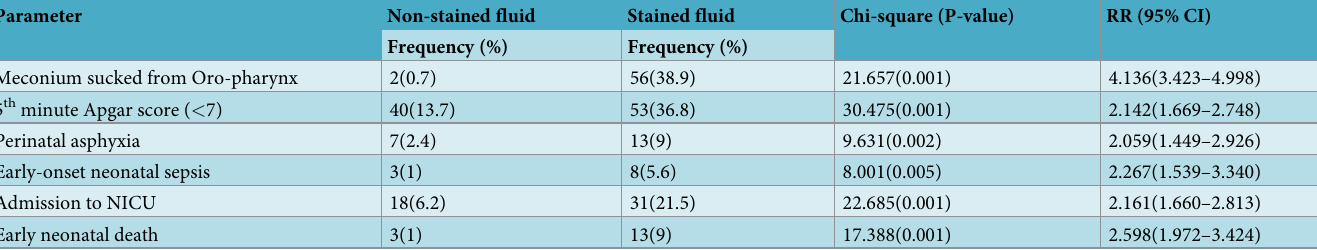
Table 4. Perinatal outcome of laboring mothers at SPHMMC from July 1 to December 30, 2018.